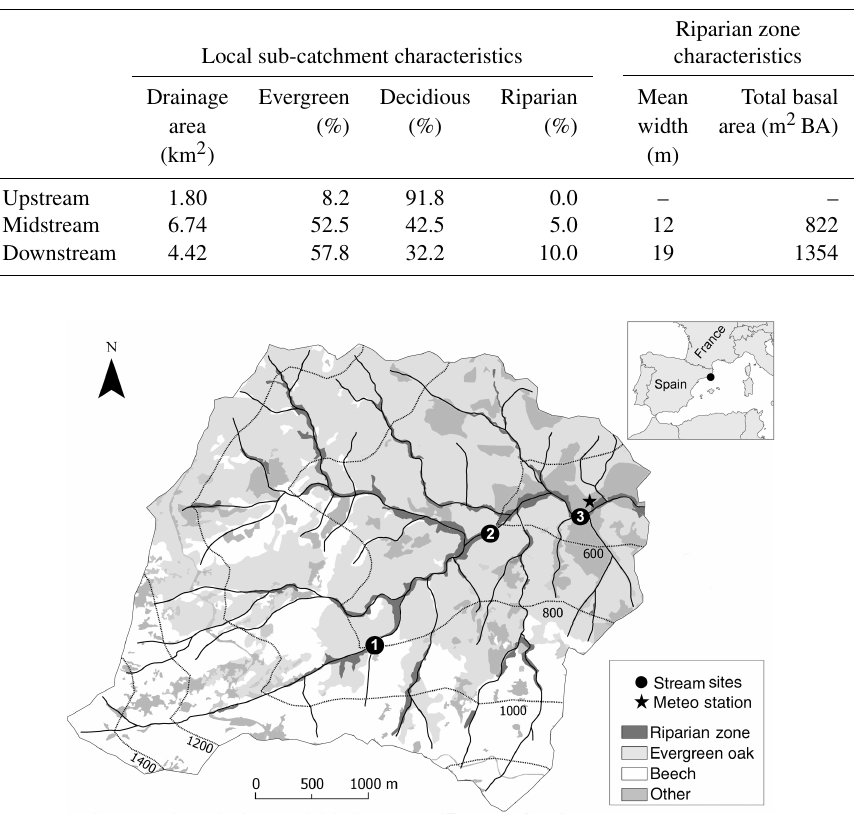
Figure 1. Map of the Font del Regàs catchment showing the different land covers (landscape units), the catchment elevation (dotted lines, 500–1500m), the location of the three nested stream sites (black circles; 1: upstream; 2: midstream; and 3: downstream), and the meteo- rological station where precipitation and temperature were measured (star). The location of the Font del Regàs catchment within Spain is shown in the